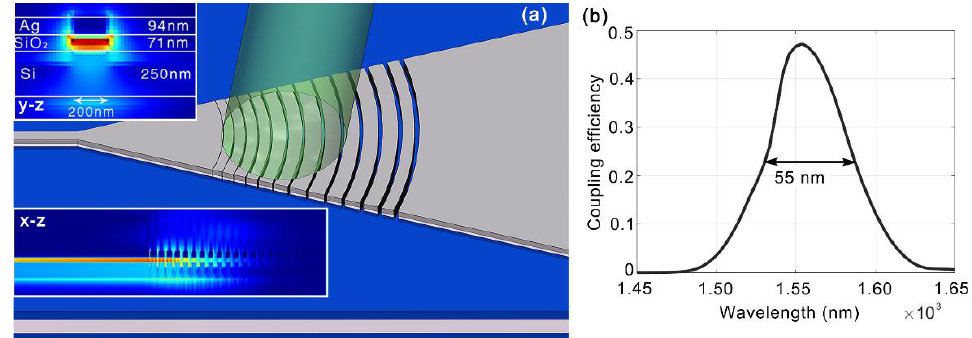
Figure 6. ( a ) 3D schematic of the silicon HPW-fiber coupler. Here, the HPW has a Si slab/rib structure and a metal cap. The upper and lower insets show the mode profile of the TM 0 mode of a 200 nm-wide HPW (y-z plane) and the light propagation (x-z plane), respectively. ( b ) Simulated transmission spectrum from the fiber to the 200 nm-wide HPW.